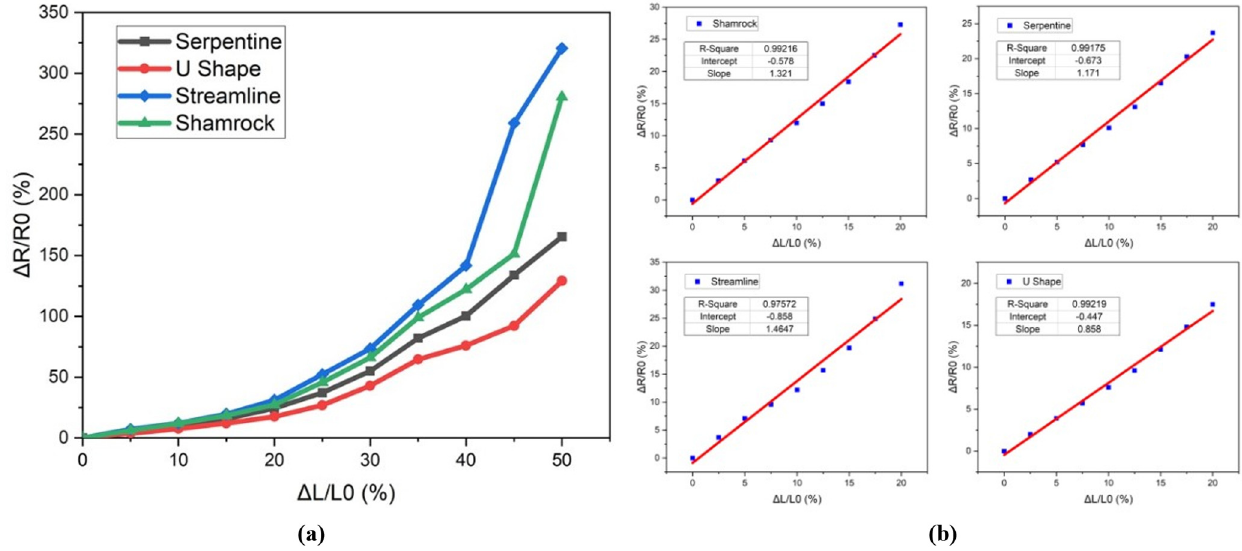
Figure 4. ( a ) Comparisons of four various structured sensors under same dynamic loading; ( b ) Linear fitting results of four different shapes of sensors when the deformation variable is between 0-20%.